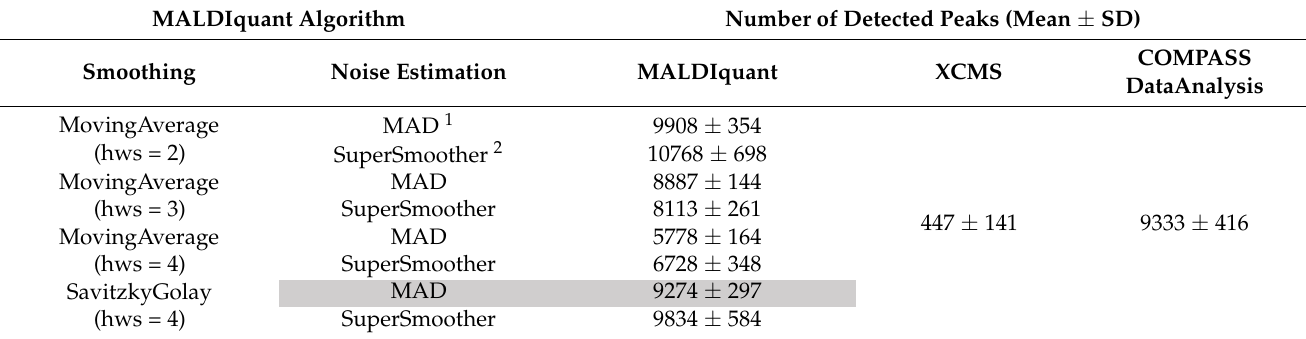
Table 1. The number of peaks detected using different intensity smoothing and noise estimation